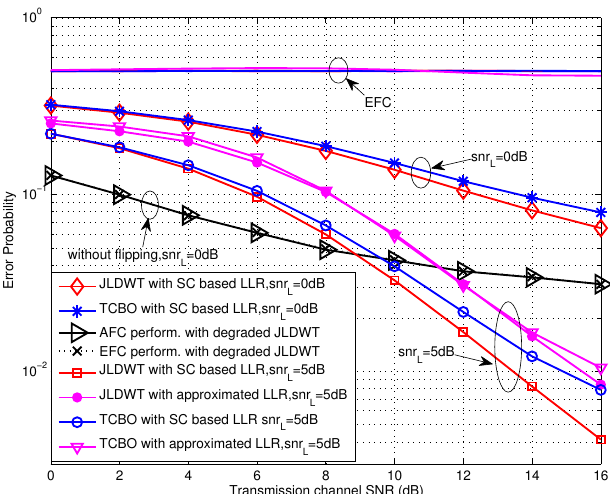
Figure 9. Error probabilities of TCBO and JLDWT schemes as functions of various SNR for β = 0.8 over high SNR region.